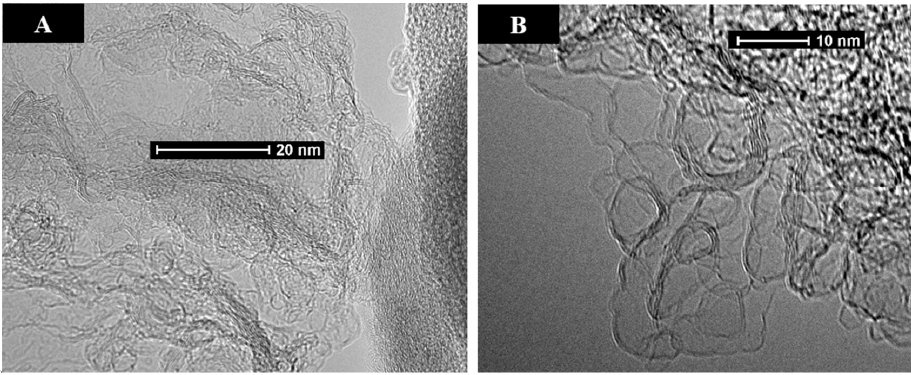
Figure A10. ( A ) TEM micrographs of anthracene coke ( B ) and sucrose char—50 mJ/cm 2 .